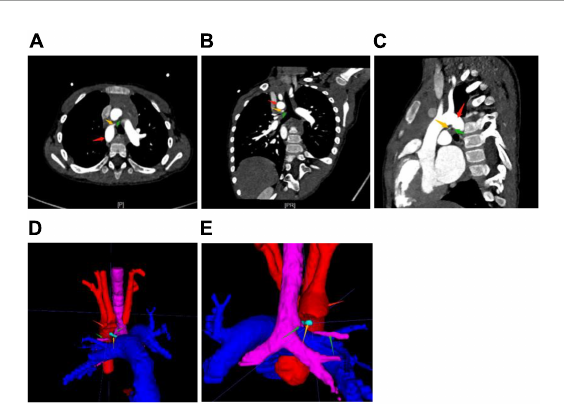
FIGURE2 Computed tomography angiography [CTA, (A–C) horizontal, coronal, and sagittal] and [3-D reconstruction (D,E) front, back] show the right aortic arch (red arrow) and right ductus arteriosus (yellow arrow) with right tracheal bronchus (green arrow). The aorta and pulmonary artery are located in an anteroposterior relationship. In a normal conformation, even with the right aortic arch, the aorta is located to the right of the pulmonary artery. In addition, the left brachiocephalic artery and the right common carotid artery have a common trunk. This is the so-called bovine arch, a normal variant. The right tracheal bronchus, from the tracheal wall above the carina, runs in the "H"-shaped structure formed by the right aortic arch, right patent ductus, and right pulmonary artery.